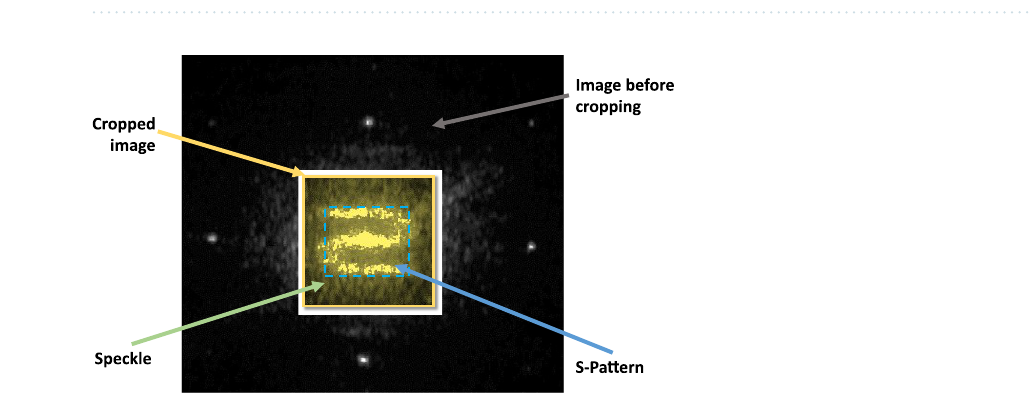
Figure 5. Performance under extreme perturbation of experimental conditions (Engraving BD7): Histogram ( a ) shows intra- and inter-class distances, sub-figure ( b ) shows POC from the 3 time points within a week for cropped images, S-pattern and speckle, and sub-table shows the assessment criteria.